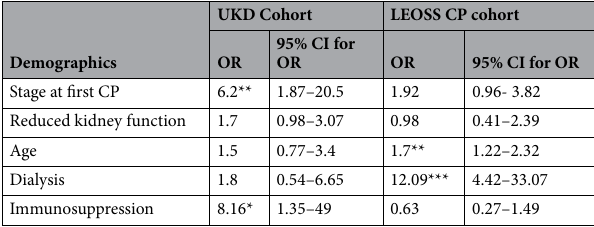
Table 3. Binary logistic regression to identify risk factors for death.